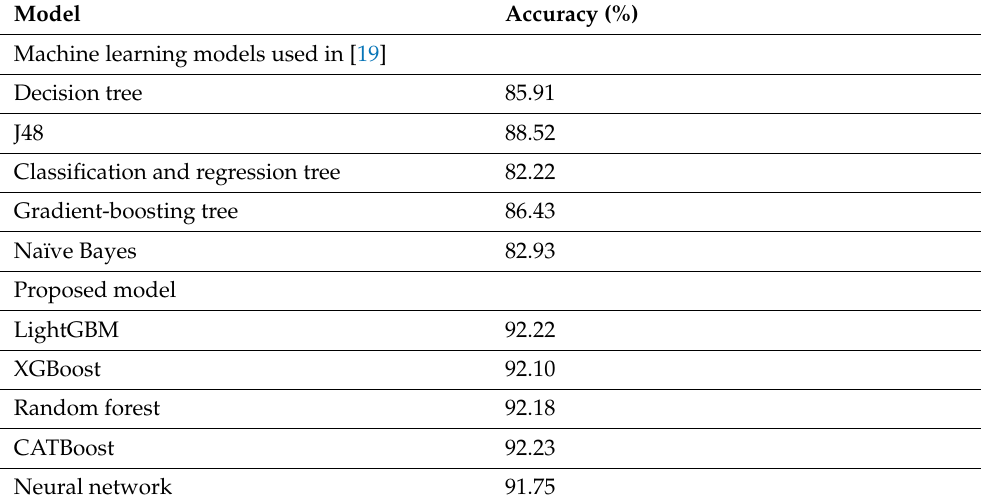
Table 4. Accuracy